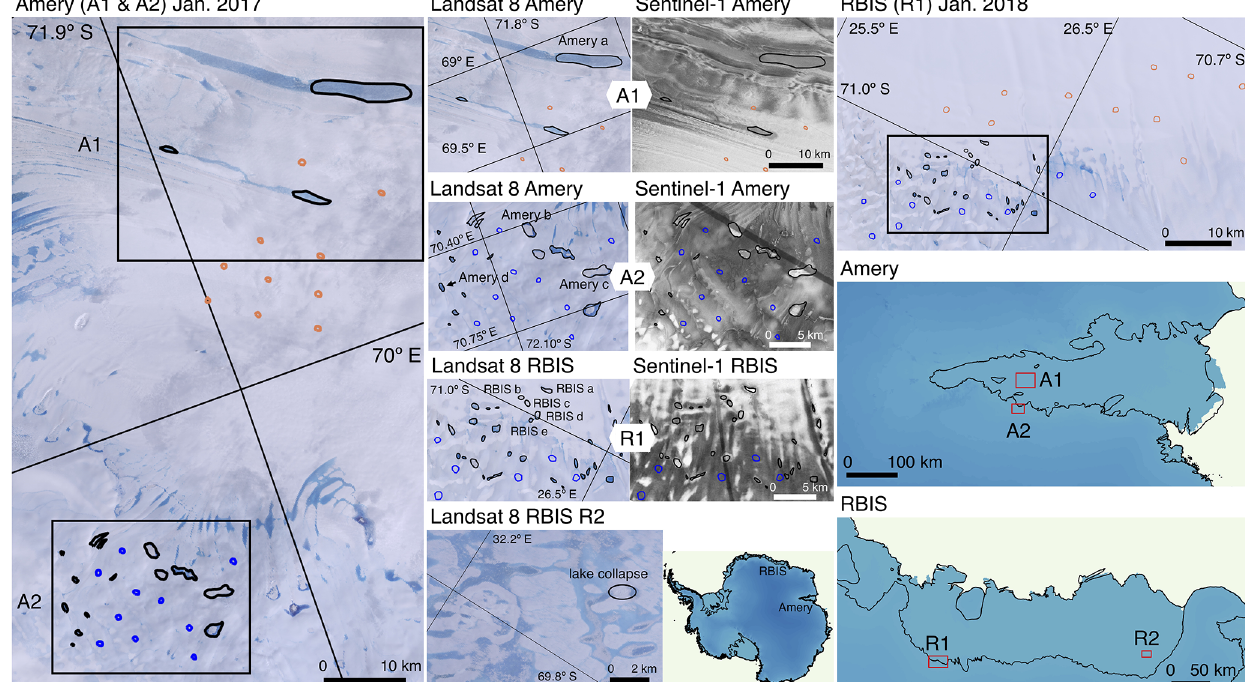
Figure 1. Outline of the Amery and Roi Baudouin ice shelf (RBIS) study areas (referred to as A1, A2, R1 and R2). Details of the investigated meltwater features are shown in both Landsat 8 true colour images and Sentinel-1 backscatter intensities. The images are acquired from Google Earth Engine (Gorelick et al., 2017). In all panels, the lakes used for the temporal backscatter and coherence analysis are delineated as black curves. The labels of the lakes correspond to the time series in Fig. 3. Snow (in orange) and ice (in blue) are also delineated for comparison against backscatter intensity and coherence values observed over lakes (Fig. 3). Panel R2 illustrates the lake feature shown in Fig. 9. The analysed ice shelves are highlighted on the Antarctica map, and the specific locations of A1, A2, R1 and R2 are shown on the Amery and RBIS maps. The DEM used as the background is from the REMA project (Howat et al., 2019), courtesy of the Polar Geospatial Center. The coastline is from the SCAR Antarctic Digital Database (Gerrish et al.,